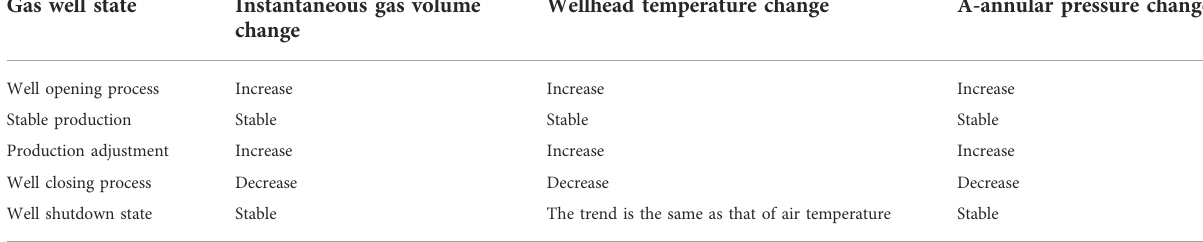
TABLE 1 Law of variation to gas well working condition parameter.